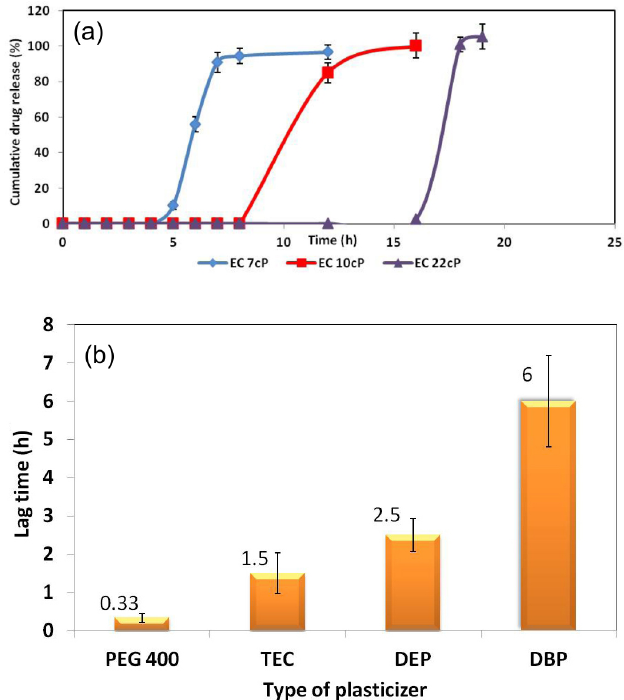
FIGURE 4 – (a) Effect of different grades of ethyl cellulose on time lag and in-vitro release profile (b) Effect of type of plasticizer on time lag (PEG 400: Polyethylene glycol 400, TEC: triethyl citrate, DEP: diethyl phthalate, DBP: dibutyl phthalate).